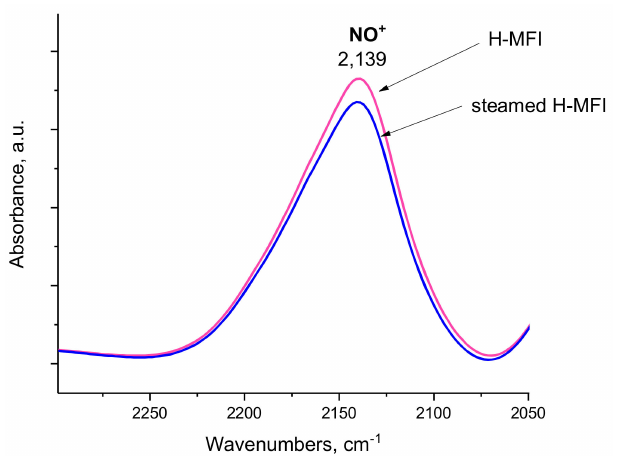
Figure 5. FTIR spectra in the N-O stretching region: a comparison of parent H-MFI (containing no EFAL) and steamed H-MFI (containing EFAL). NO + was produced by NO 2 adsorption (0.5 Torr in total). Because NO + occupies H sites, it is a direct measure of changes in Bronsted acid quantity and acidity. The total number of Bronsted acid sites decreased after steaming, evidenced by a diminished peak area and no evidence of increased Bronsted acidity is shown (no shift in the NO + stretch). As such, the preponderance of data suggests that Al 2 O 3 clusters formed during steam treatment are responsible for the increased cracking activity of the steamed H-MFI zeolite, but it is not yet shown how micro-cluster domains of alumina promote this catalytic transformation. It is now shown by us spectroscopically (Figure 6), that dehydroxylated O 5 Al(VI)-OH sites (i.e., penta-coordinate Al 3+ ions) are capable of heterolytically breaking the C-H bond of methane, the hydrocarbon with the most inert bonds and the hardest to activate, at temperatures as low as 200 ◦